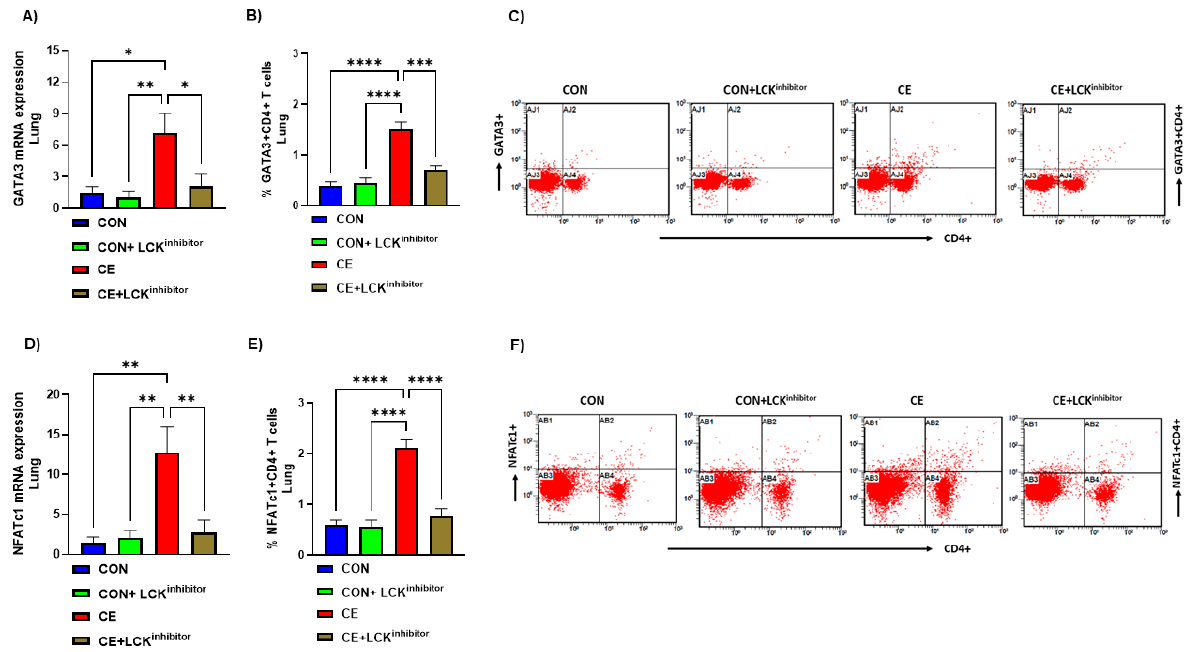
Figure 4. Attenuation of Th2 transcription factor signaling by LCK inhibitor in CE-exposed allergic mice. ( A ) GATA3 mRNA expression in lung tissue, ( B ) % GATA3+CD4+ T cells, ( C ) Flow plot with representative depiction of double positive immunostaining in CD4+ T cells, i.e., GATA3+ immunoreactivity in CD4+ T cells, ( D ) NFATc1 mRNA expression in lung tissue, ( E ) % NFATc1+CD4+ T cells, and ( F ) Flow plot with representative depiction of double positive immunostaining in CD4+ T cells, i.e., NFATc1+ immunoreactivity in CD4+ T cells. Data are presented as mean ± SE, n = 6/group. * p < 0.05; ** p < 0.01; *** p < 0.001; **** p < 0.0001.